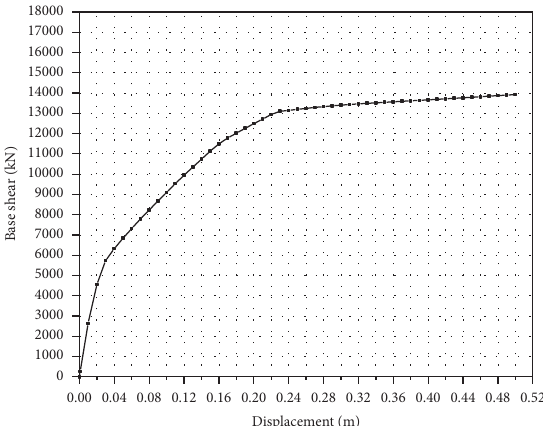
Figure 28: Base shear force-displacement curve of IAJB.